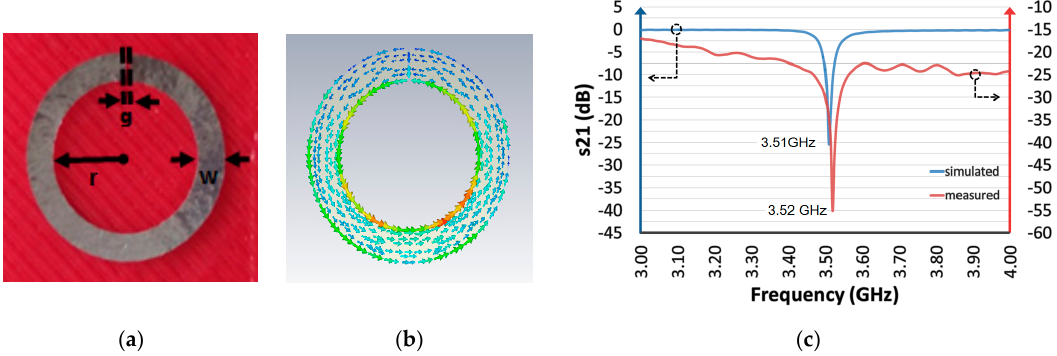
Figure 2. ( a ) A photograph of the sample SRR; ( b ) Simulated surface current density for this device at resonant frequency; ( c ) Simulated (blue) and measured (red) s 21 spectra of the sample